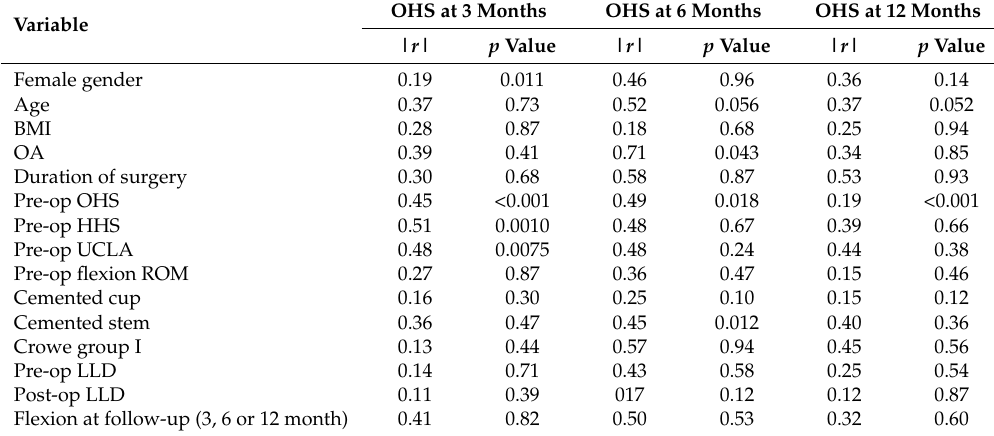
Table 7. Correlation coefficients and p values obtained for each variable by multivariate regression